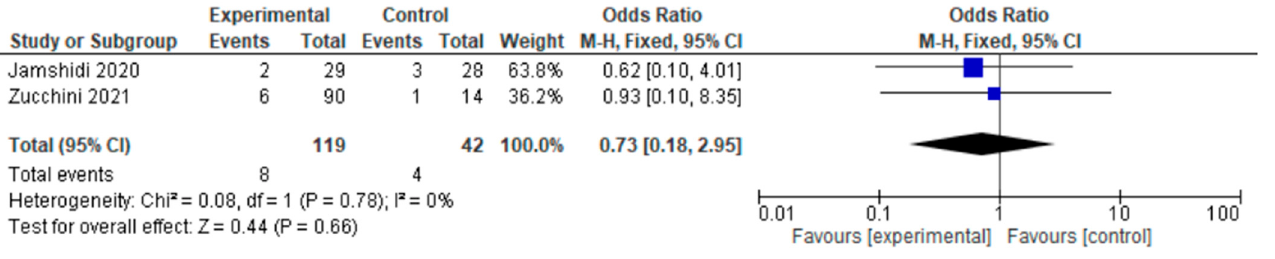
Figure 3. Forest plot of infection comparing in proximal femur tumor patients undergoing HA and THA. and THA